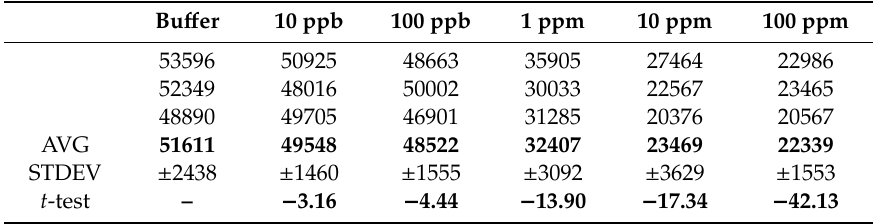
Table A3. Raw numbers and statistical analysis of the data shown in Figure 3. Area under the response curve from replicates in the Attenu assay is shown in the first 3 rows. The concentration of feces tested is listed on top. Averages and statistical analysis are shown in the last 3